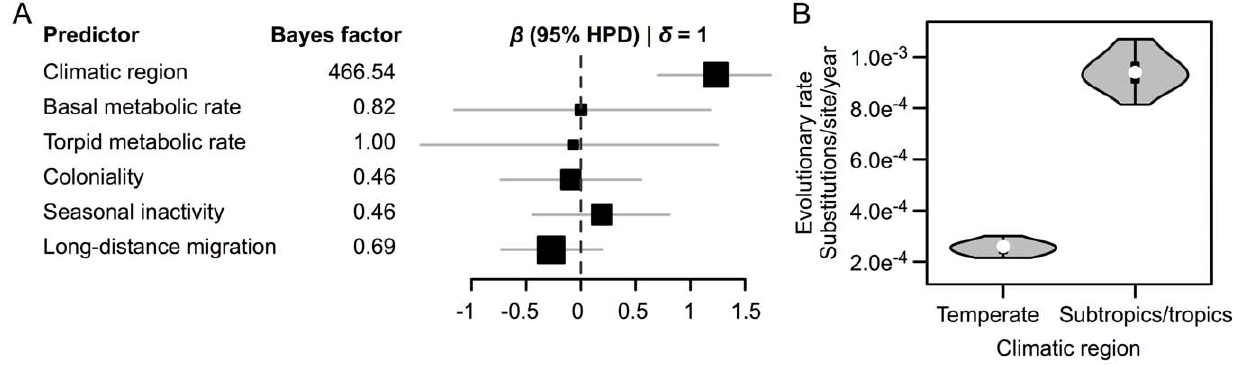
Figure 3. Predictors of viral evolutionary rate from the Bayesian hierarchical phylogenetic model. (A) Effect sizes ( b ) on a log scale for each predictor were conditioned on the inclusion of that term in the model (i.e., b | d =1). Climatic region, coloniality, seasonal inactivity and long distance migration were categorical variables. Horizontal lines are the 95% highest posterior density intervals on conditional effect sizes and squares (median effect sizes) are proportional to effect sizes. (B) Violin plot showing the effect of climatic region on viral evolutionary rate. White points, black boxes and whiskers indicate the median, inter-quartile range and the total range of values for that group, respectively. The gray shading shows the probability density of evolutionary rate at different